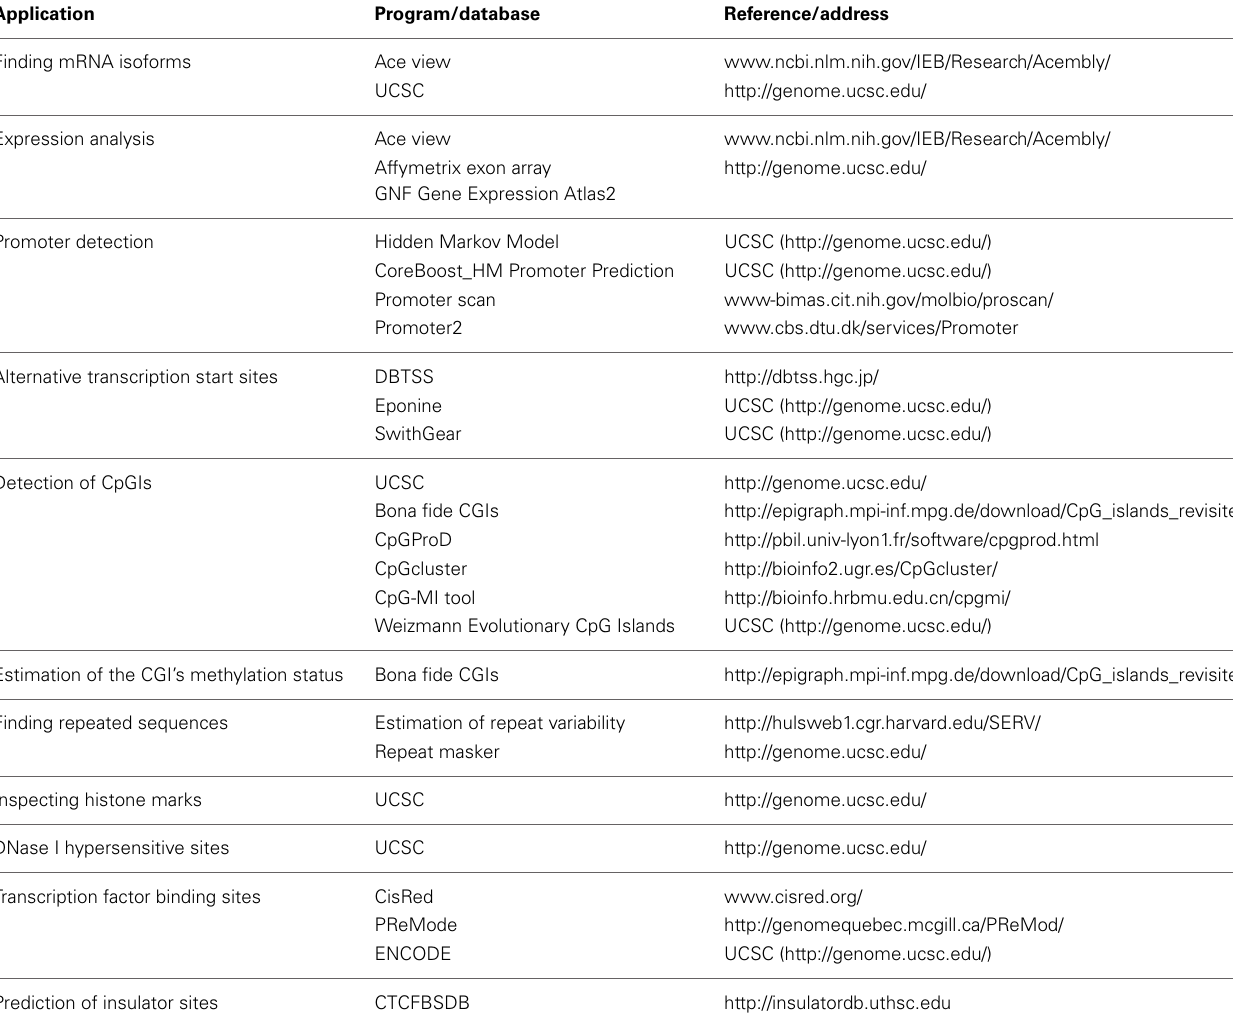
Table 1 | Databases and softwares used in this